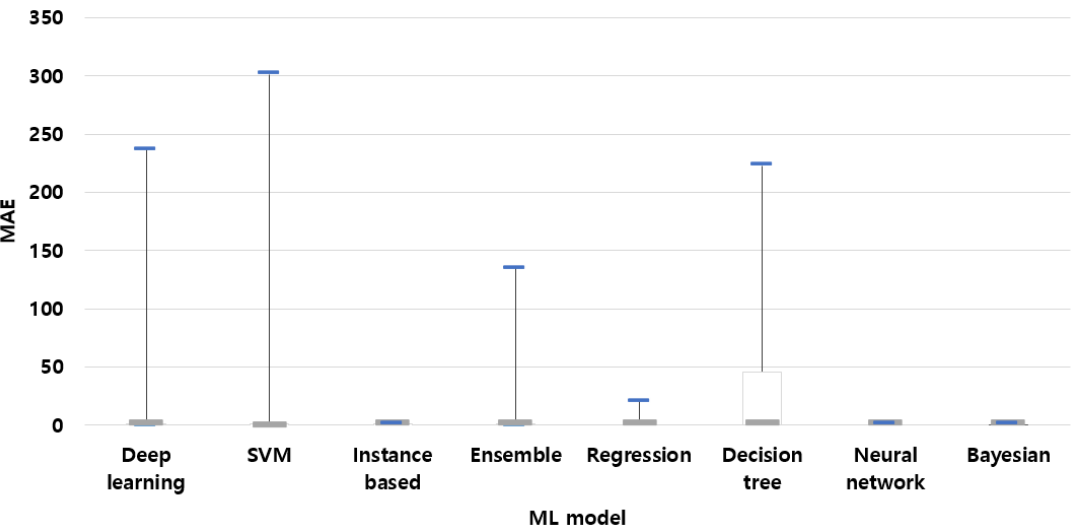
Figure 16. Box plots for MAE.